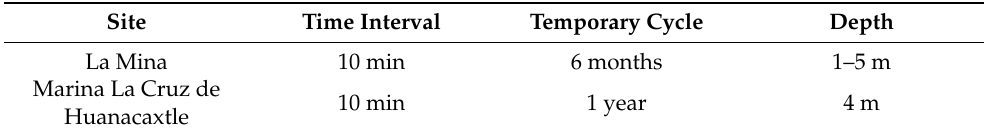
Figure 2. HOBO Water Temp Pro v2 with data loggers. Table 1. Measurement of surface and deeper water (SST) in situ .